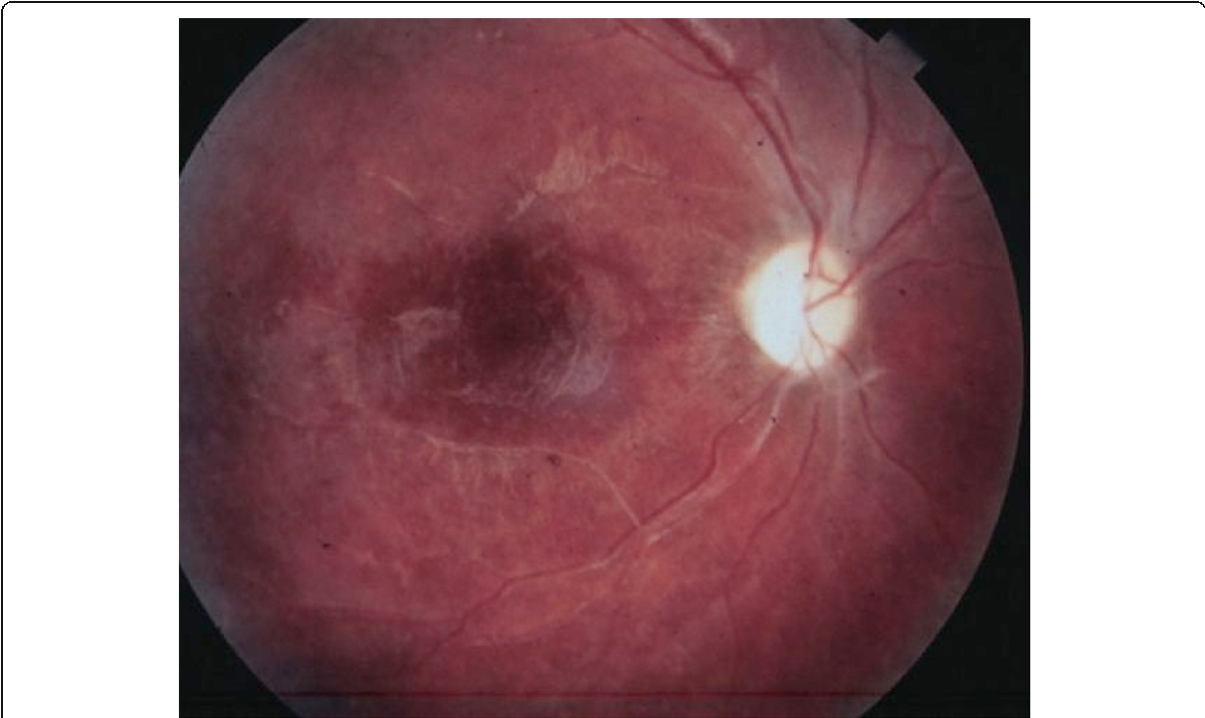
Fig. 2 In the later stage of DUSN, patient fundus presented with a pale optic disc, narrowed retinal vessels, and pigmentary